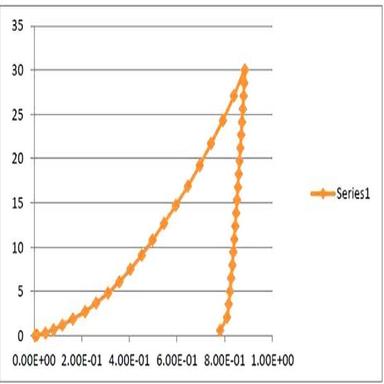
Graph between indentation depths vs. hardness for 2%.